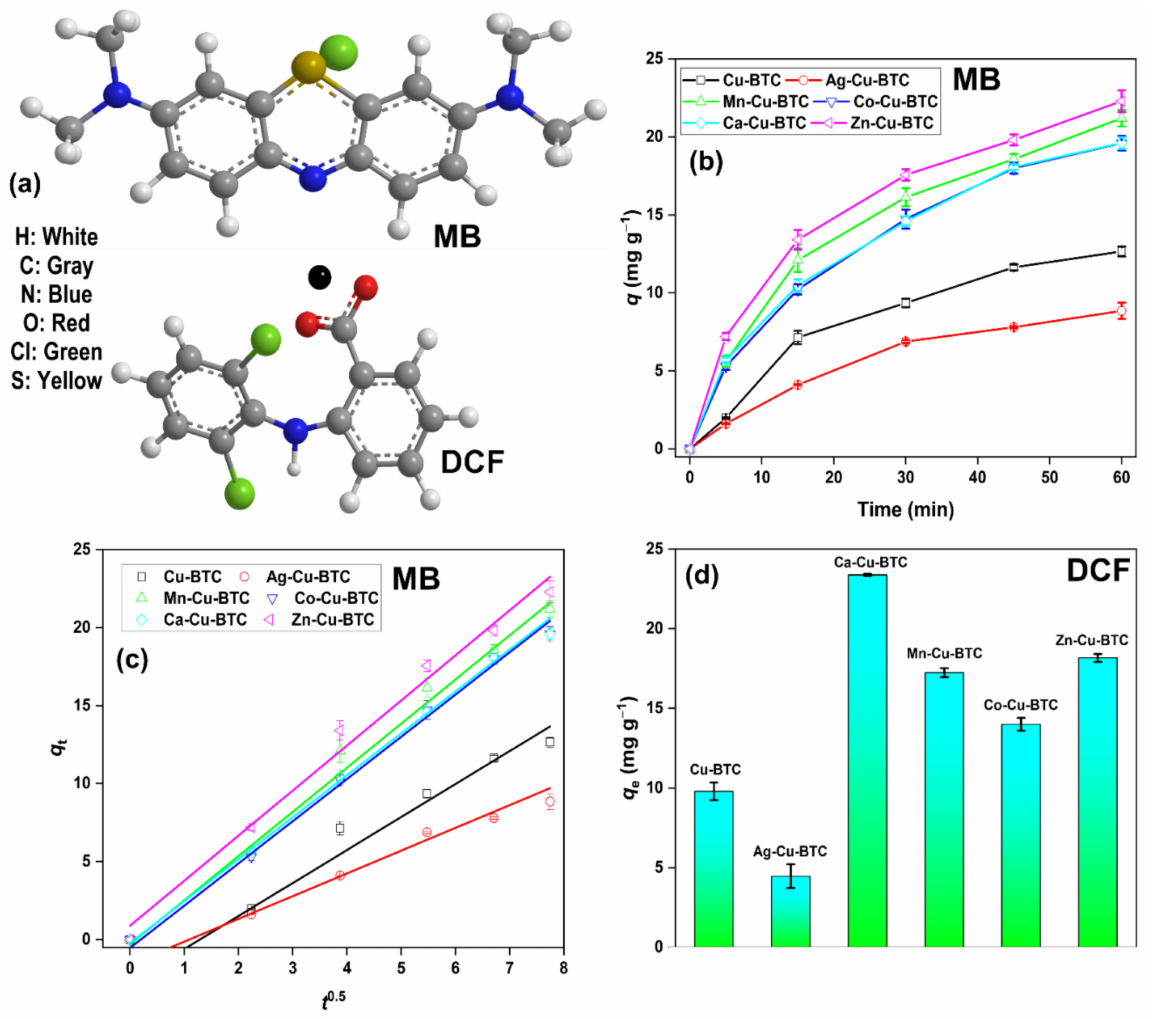
Figure 5. ( a ) Molecular structure of MB and DCF; ( b ) MB dye adsorption behavior of synthesized MOFs; ( c ) kinetic data fitted to the IPD model; ( d ) DCF adsorption capacity of MOFs after 1 h of